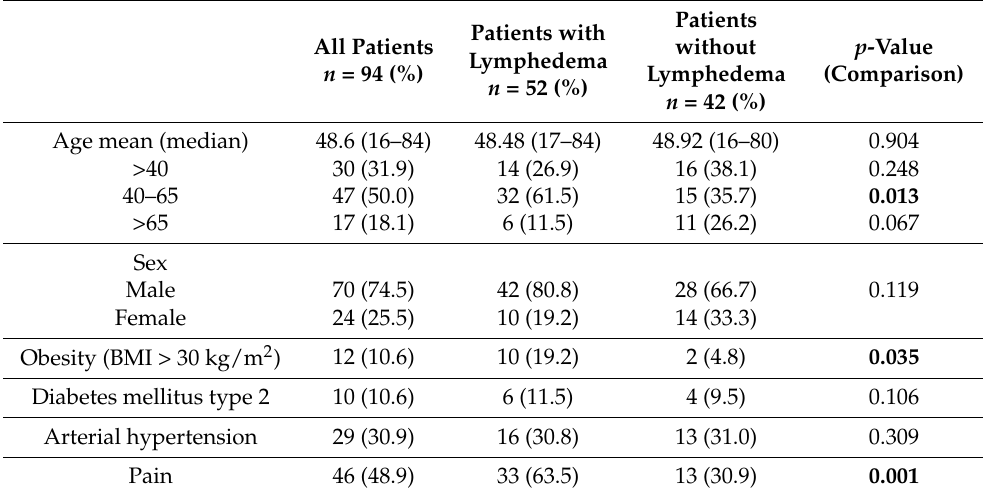
Table 1. Patient